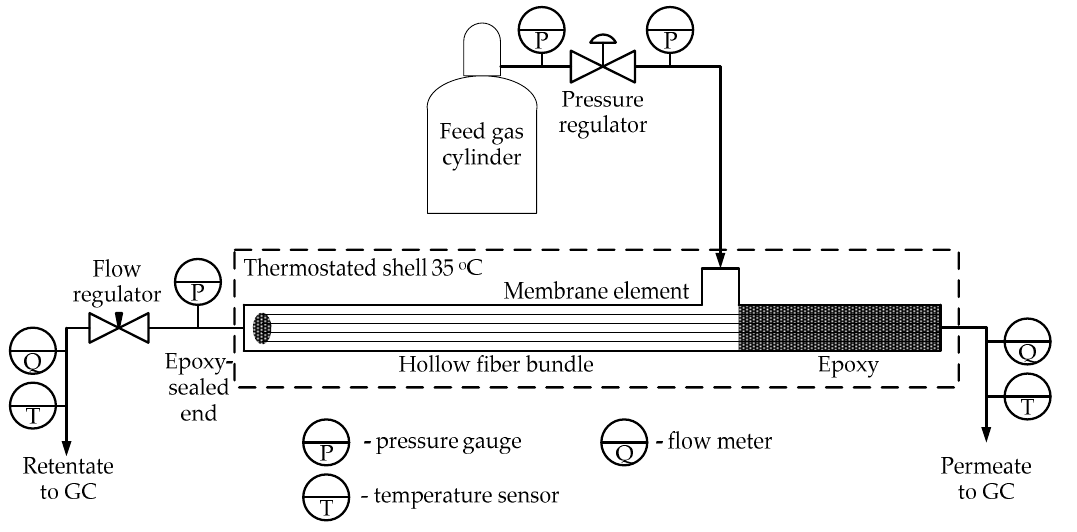
Figure 2. Experimental set-up for mixed-gas tests of the membrane element.